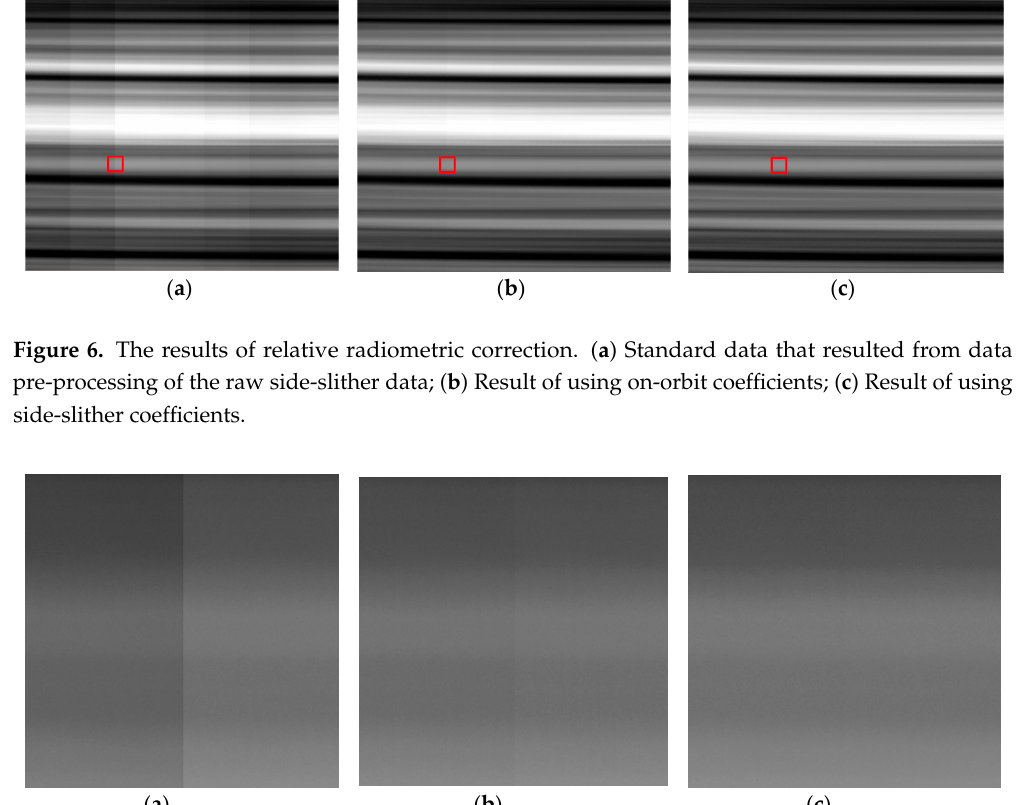
Figure 7. The detail of results. ( a ) Detailed image of the red box showed in Figure 6a; ( b ) Detailed image of the red box showed in Figure 6b; ( c ) Detailed image of the red box showed in Figure 6c. Due to the characteristics of side-slither data, the column mean clearly reflected the effects of the coefficients. Figure 8 shows the column mean value analysis of the standard image and corrected images. The abscissa represents the detector number, and the ordinate represents the DN value of the column mean of each detector. Figure 8a shows the column means of the standard image. It is apparent that the column mean value of the standard image exhibited large variation, with a range of variation of about 40 DN, which is consistent with the image shown in Figure 6a. Figure 8 shows that there are seven detector groups. The responses between the detector group were very different, so the changes of the mean were very noticeable, resulting in the significant non-uniformity between the detector group shown in Figure 6a. The responses of the detectors inside each detector group were similar, and the variations of the mean were not significant, while the non-uniformity inside the detector group were not obvious shown in Figure 6a. Figure 8b shows the column means of the images corrected using the on-orbit coefficients and side-slither coefficients. The blue curve represents the correction results from using the on-orbit coefficients and the red curve represents the correction results using the side-slither coefficients. It is obvious that the range of variation was smaller, about 6 DN, and that the on-orbit corrected image exhibited non-uniformity shown by the blue curve. On the other hand, the side-slither coefficients performed well; the range of variation was about 2 DN for the red curve. For further analysis, streaking metrics analyses were performed.